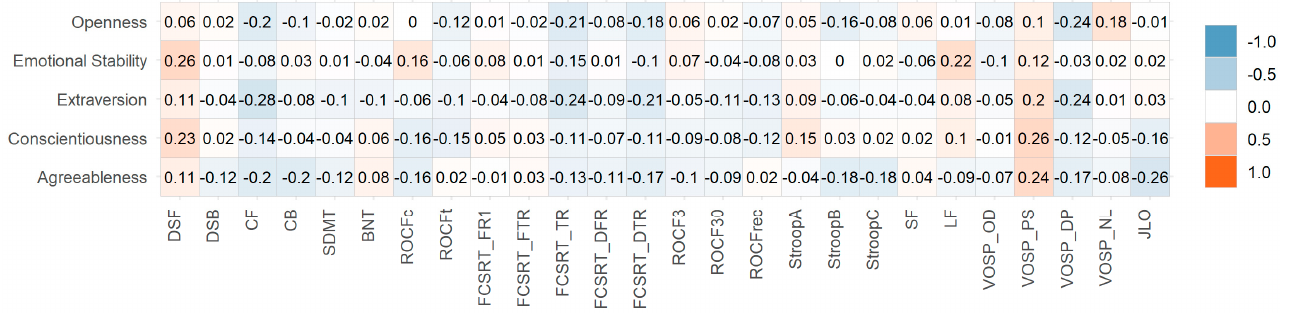
Figure 2. Heatmap of Pearson correlation coefficients between neuropsychological tests and per-